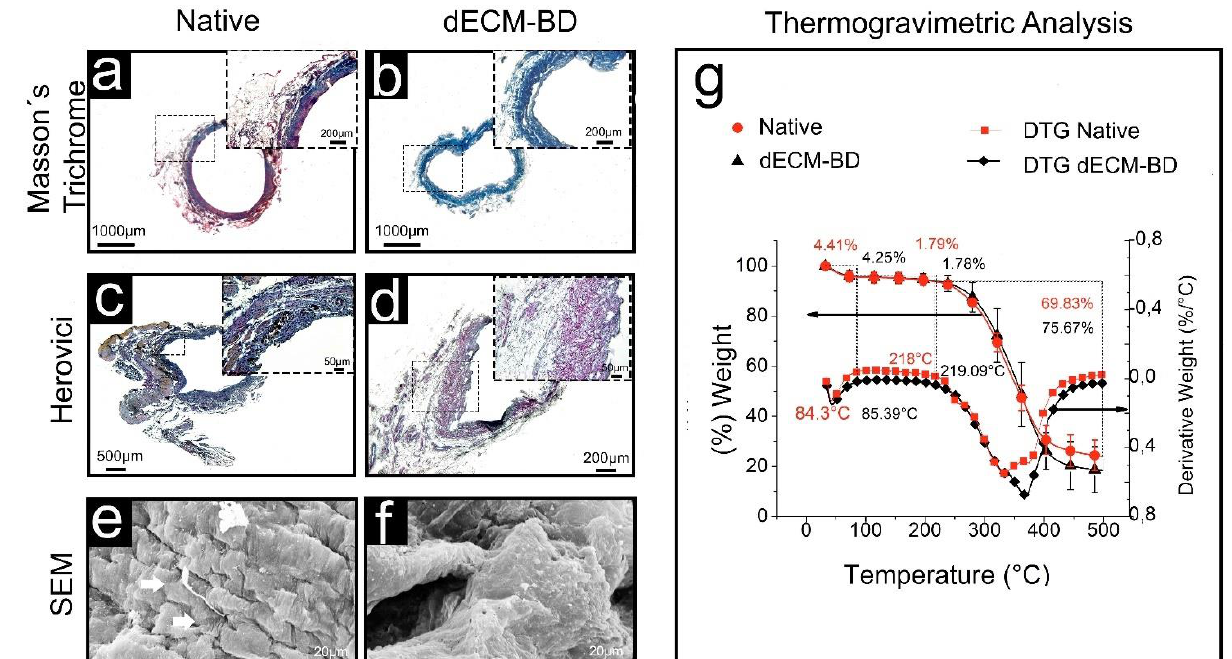
Figure 3. Characterization of the dECM-BD. Masson's trichrome stain of native ( a ) and decellularized bile duct (dECM-BD) ( b ), Herovici stain of native ECM ( c ), and dECM-BD ( d ). Scanning electron microscopy (SEM) microphotographs of dECM-BD samples and native. The epithelium is observed in the sample from the bile duct with primary cilia indicated by the white arrows ( e ). Decellularized sample in which cellular material is absent in pores, and microvilli, with evidence of conserved extracellular matrix ( f ). Thermogravimetric analysis (TGA) results from native and decellularized samples. DTG: derivate thermogravimetric ( g ).